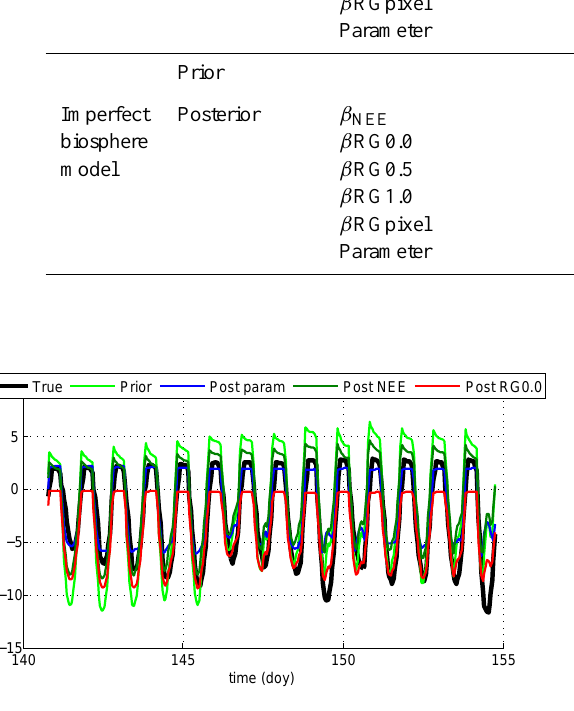
Fig. 5. Time series of aggregated true, prior, and posterior fluxes for the dominant land use type in the domain, Crops1. The figure illustrates the different temporal behavior of each solution on hourly time scales, leading to differences in two-week aggregated